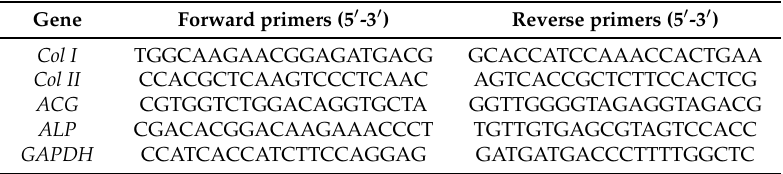
Table 1. Primer sequences used for real-time